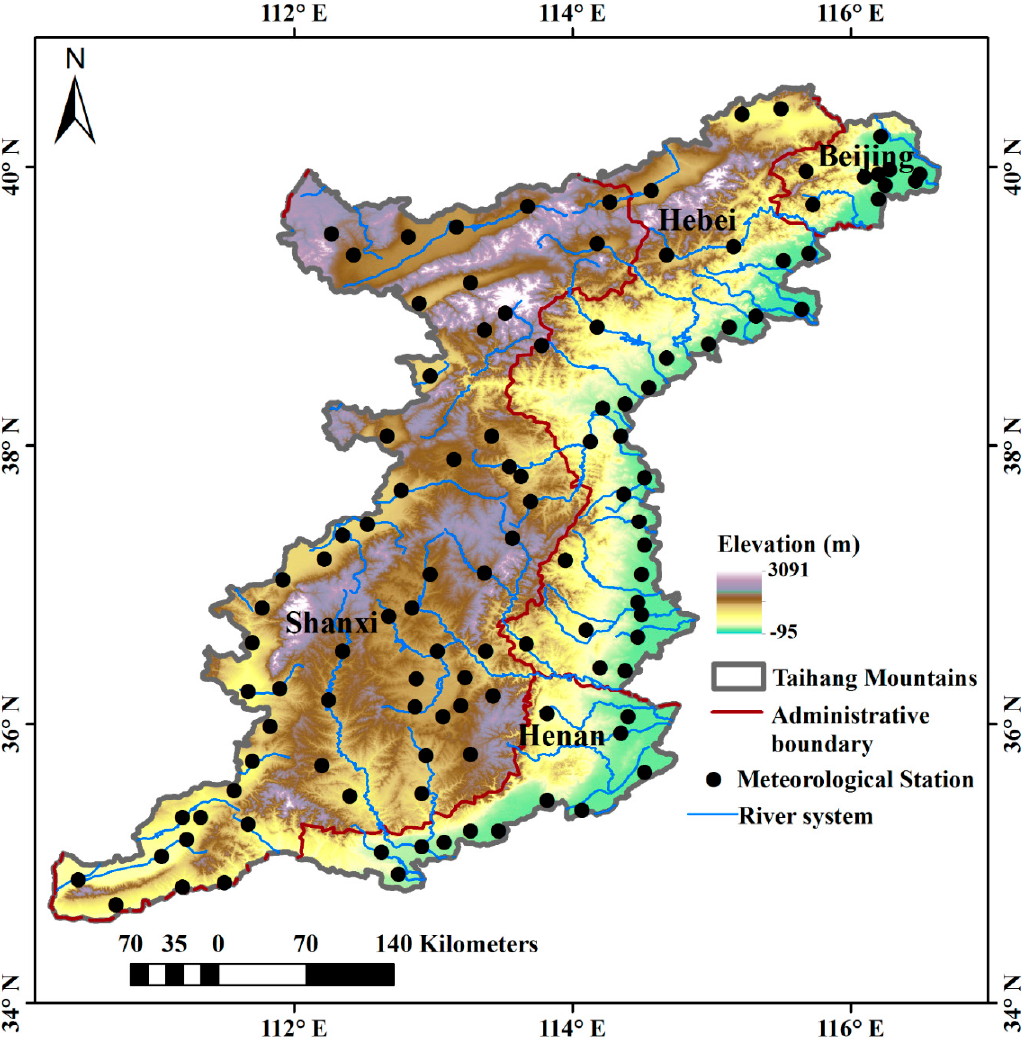
Figure 1. Regional map of the Taihang Mountains, including elevation, location of rain gauges, and river systems.